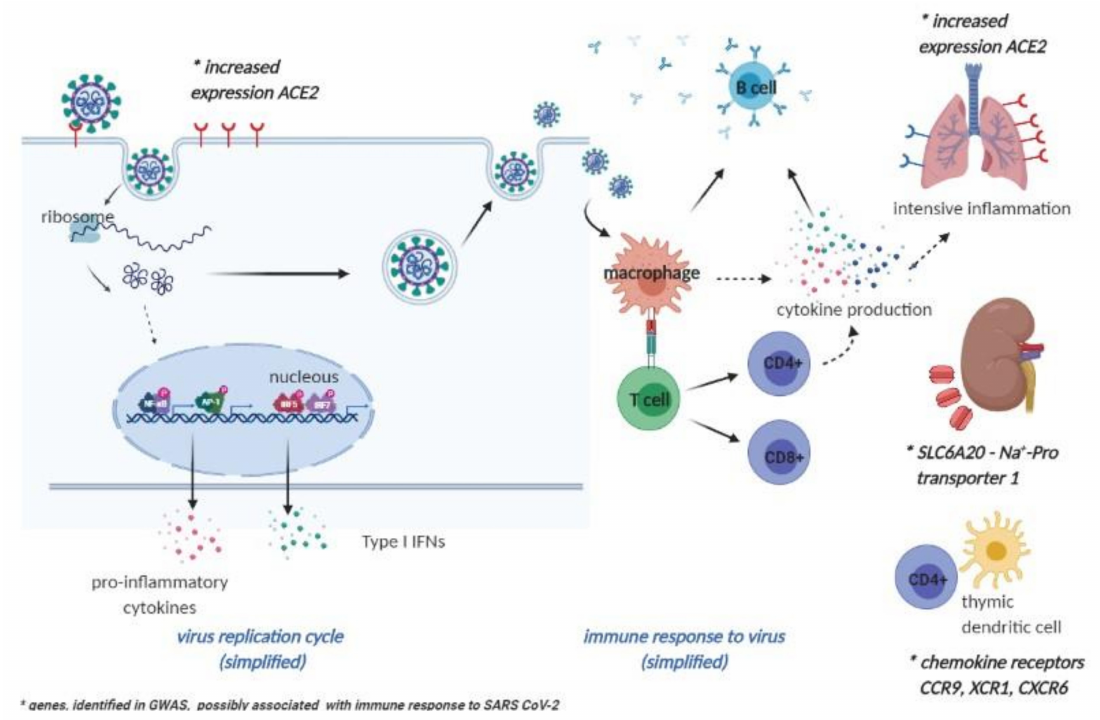
Figure 1. Genes identified in genome association studies (GWASs), possibly related to the immune response to SARS-CoV-2. (Adapted from “Coronavirus Replication Cycle”, by BioRender.com (2020). Retrieved from https: // app.biorender.com /